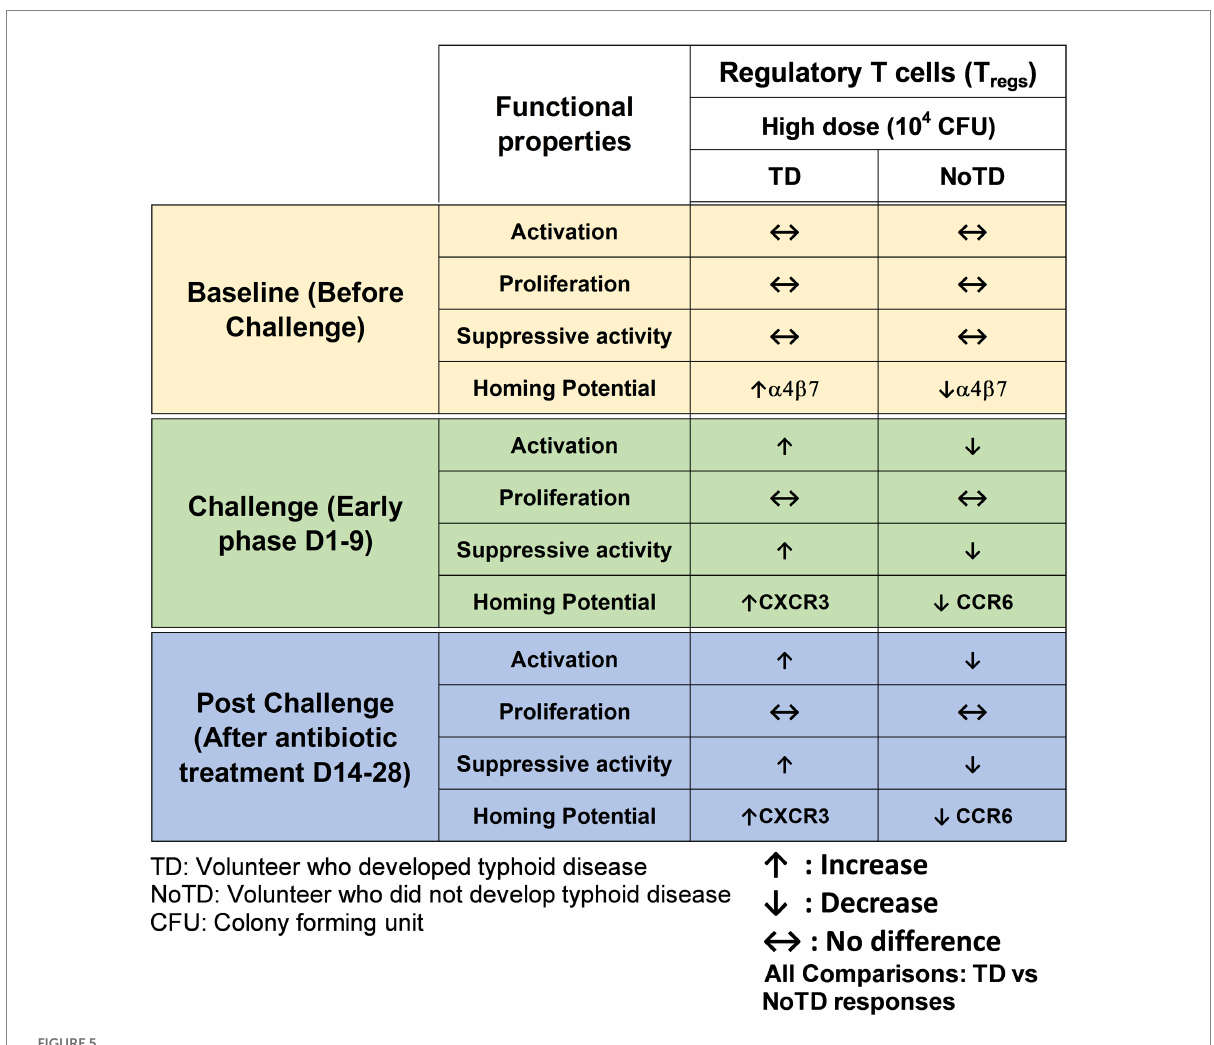
FIGURE 5 Characteristics of regulatory T cells (T regs ) in a typhoid CHIM. Summary of S . Typhi-specific T regs responses reported by McArthur et al. (2015) including comparisons between TD and NoTD at baseline (before challenge), early days after challenge (D1-9) and at later time points after challenge (D14-28). ↑ : Increase; ↓ : Decrease; ↔ : No